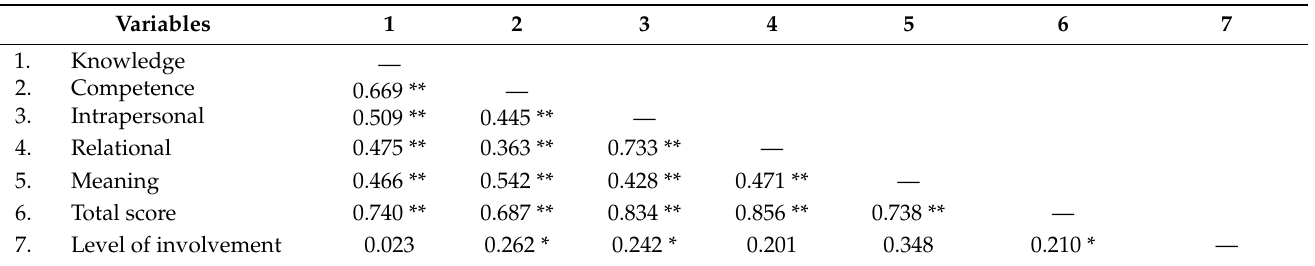
Table 4. Bivariate Pearson Correlation between the score differences in various ICF-related domains and the level of